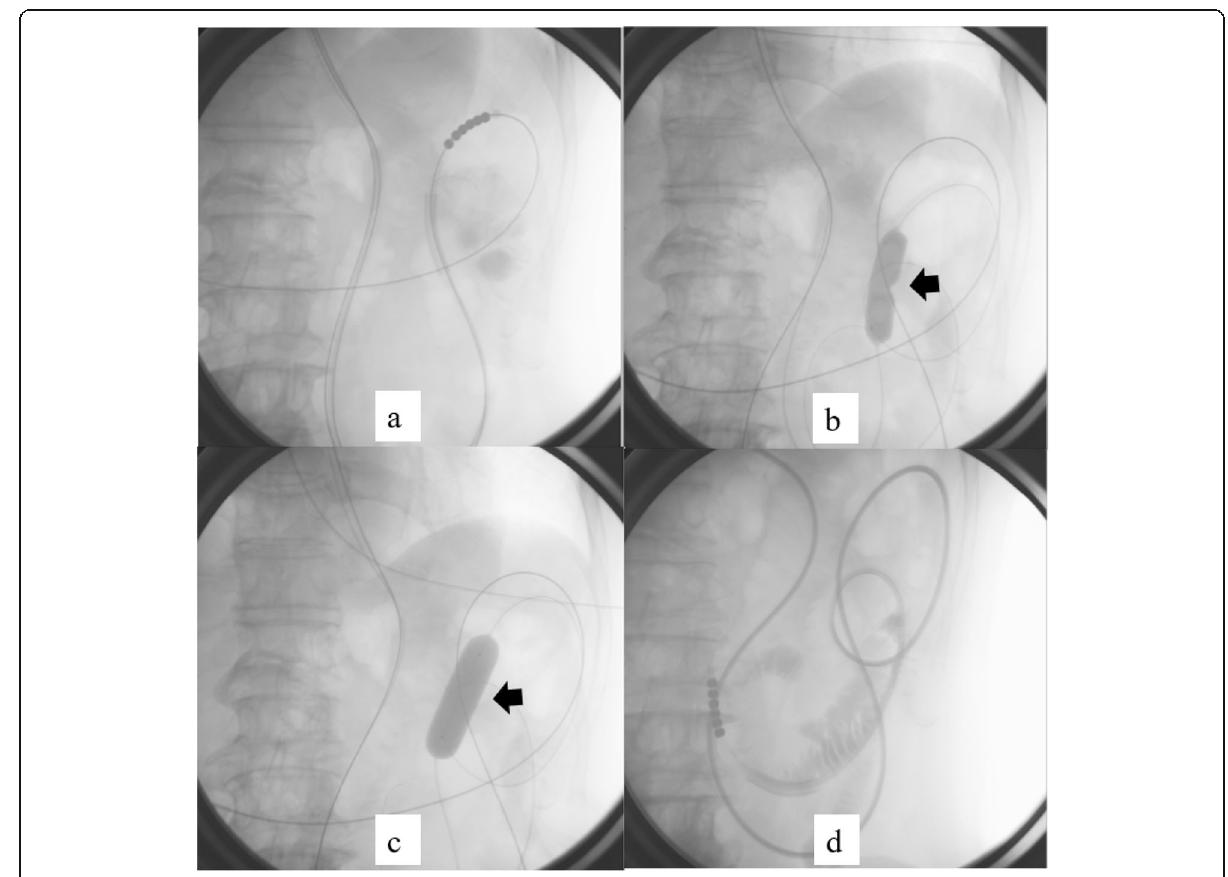
Fig. 4 a , b , c , d Fluoroscopic balloon dilation procedure (imaging of case 3). a Radiograph showing insertion of the guidewire up to the site of stenosis. b Radiograph showing the “ waist ” caused by stenosis of the jejunojejunostomy (arrow). c Radiograph showing disappearance of the “ waist ” after balloon dilation (arrow). d Radiograph showing that the ileus tube could be passed across the site of